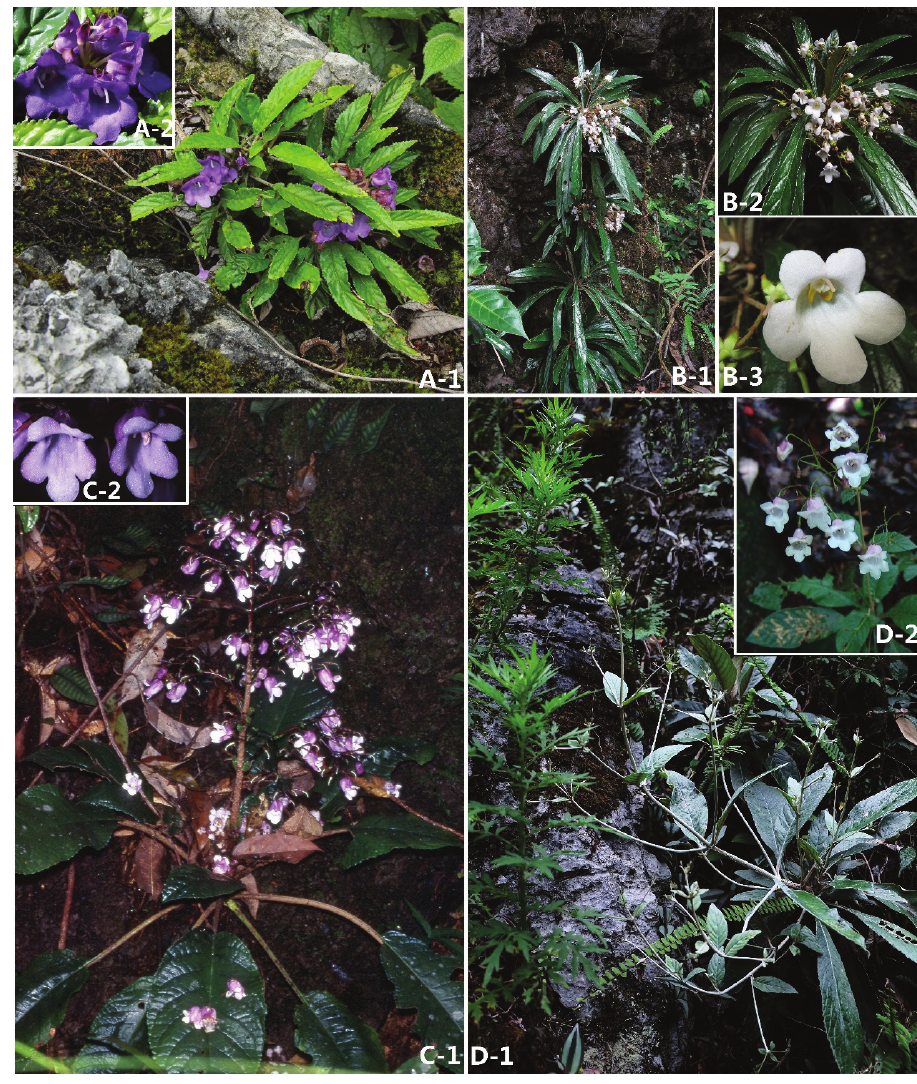
Figure 3. A: Paraboea wenshanensis X.Hong & F.Wen. A-1 plant in habitat A-2 corolla face view B P. angustifolia Yan Liu & W.B. Xu B-1 habitat B-2 flowering habit, B-3 corolla face view C P. marti- nii (Lévl.) Burt C-1 flowering habit C-2 corolla face view D P. glutinosa (Handel-Mazzetti) K. Y. Pan D-1 plant in habitat D-2 inflorescense, showing corolla face view. ca. 0.2 mm long, adnate to ca. 1.5 cm above the corolla tube base. Pistil glabrous; ovary narrowly ovoid to conical, ca. 1 cm long, ca. 1.1 mm in diameter, placentas 4, axile, undivided; style ca. 6 mm long, stigma capitate, with numerous papillae. Capsule lin- ear, spirally twisted, ca. 3 cm long, 0.4–0.6 cm in diameter, glabrous, slightly curved, dehiscing loculicidally to